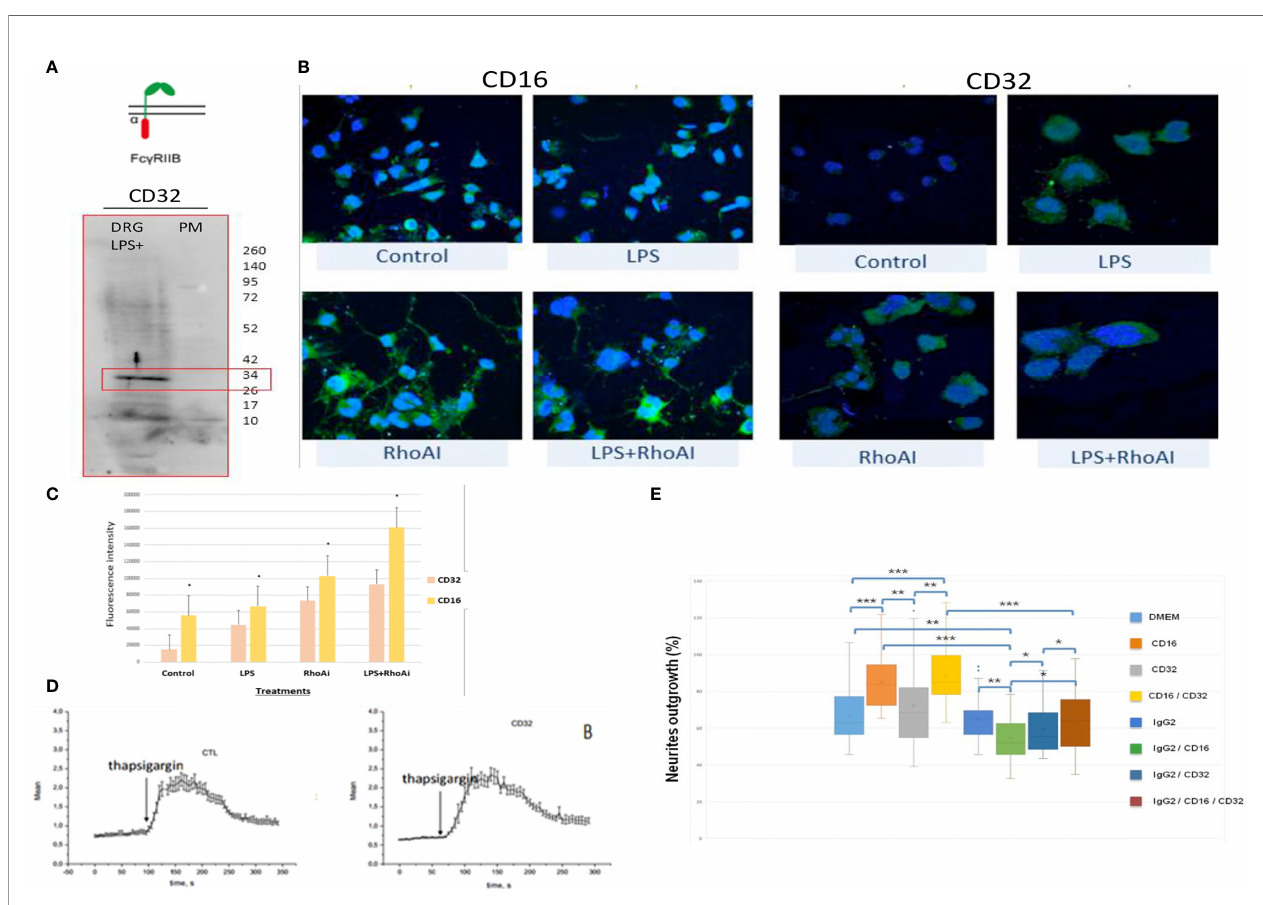
FIGURE 7 | Fc g RIIB receptor identi fi cation in sensory neurons. (A) Western blot revealing CD32b receptor in DRG cells. (B) Immuno fl uorescence performed with anti- CD16 or anti-CD32 on DRG cells stimulated with LPS and/or RhoAi. Nuclei were counterstained with DAPI (blue). (C) Quanti fi cation of CD16 and CD32b immuno fl uorescence in DRG ND7/23 cells after RhoAi and/or LPS treatments. (D) CD32b activation by speci fi c antibody in TG-activated SOCE conditions does not impact Ca 2+ homeostasis. Quanti fi cation of the results are presented in the left panel for the controls and in the right panel for CD32 activation. (E) Neurites outgrowth in DRG ND7/23 cells in the presence of speci fi c CD16 or CD32b activating antibody or CD16 and CD32b activating antibody with or without anti-GFAP. Mouse anti- GFAP displayed an IgG2 isotype and served as a control of Fc gamma receptors activation. *P value of < 0.05, **P value of < 0.01, ***P value of <